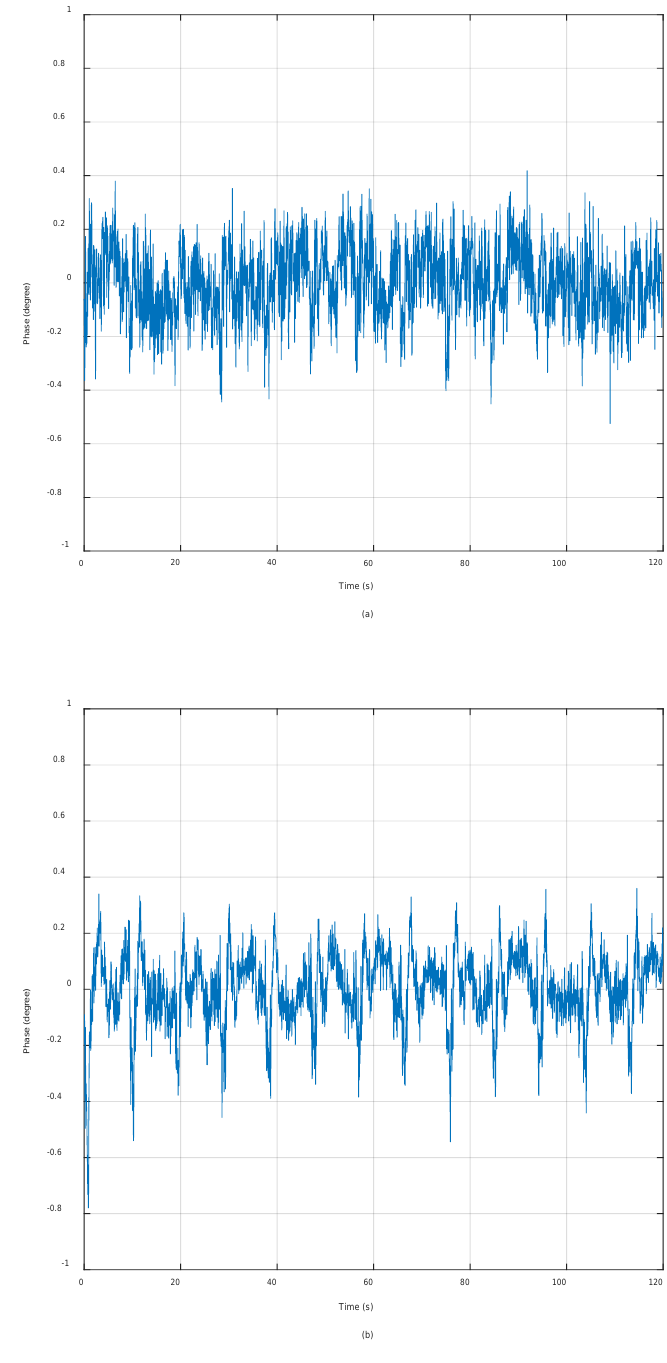
Figure 10. The residual phase error after phase synchronization compensation. ( a ) Residual phase of LFM-phase signal scheme; ( b ) residual phase of pulsed signal at carrier frequency (PSCF)-phase signal scheme.